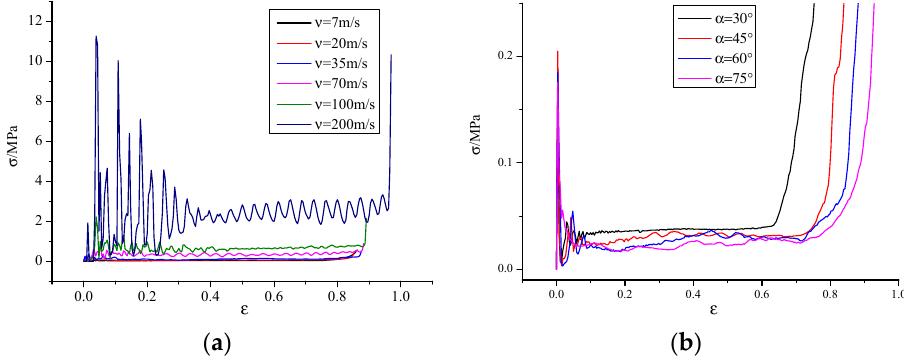
Figure 13. The relationship between nominal stress and strain of specimen. ( a ) The stress and strain of different velocities. ( b ) The stress and strain of different cell angles.